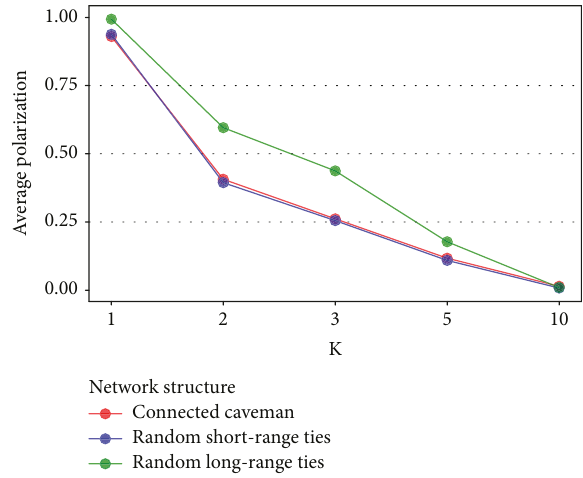
Figure 3: Reproduction of Figure 12(b) of Flache and Macy [19]. Average polarization decreases with K . However, as shown in subsequent fi gures, this does not mean trials with high polarization never obtain for large K . Average taken over 100